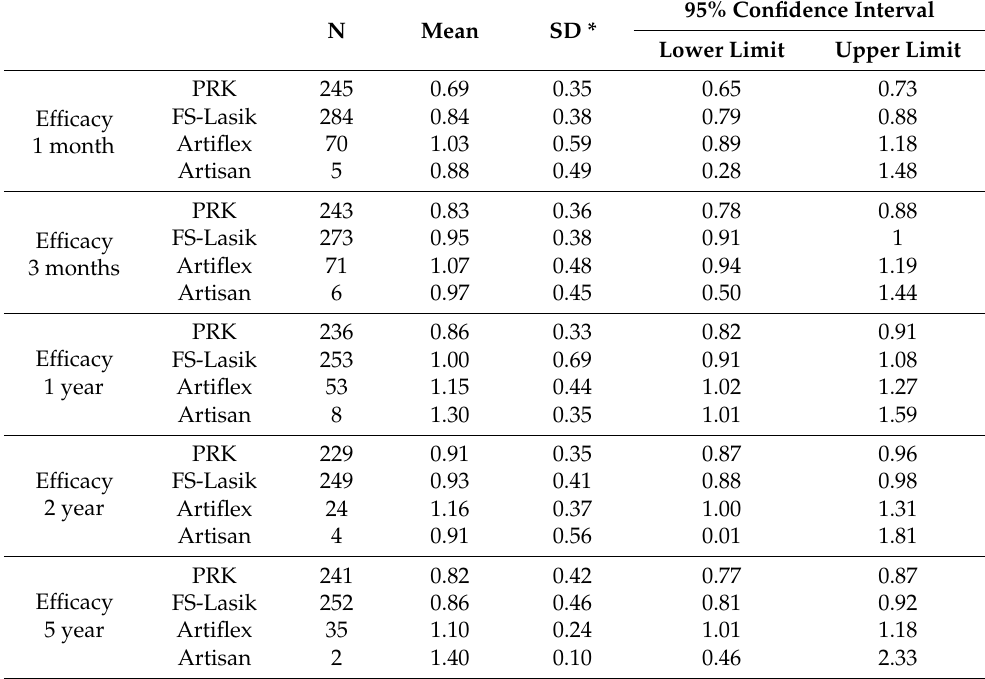
Table 1. Descriptive statistics efficacy index according to techniques.